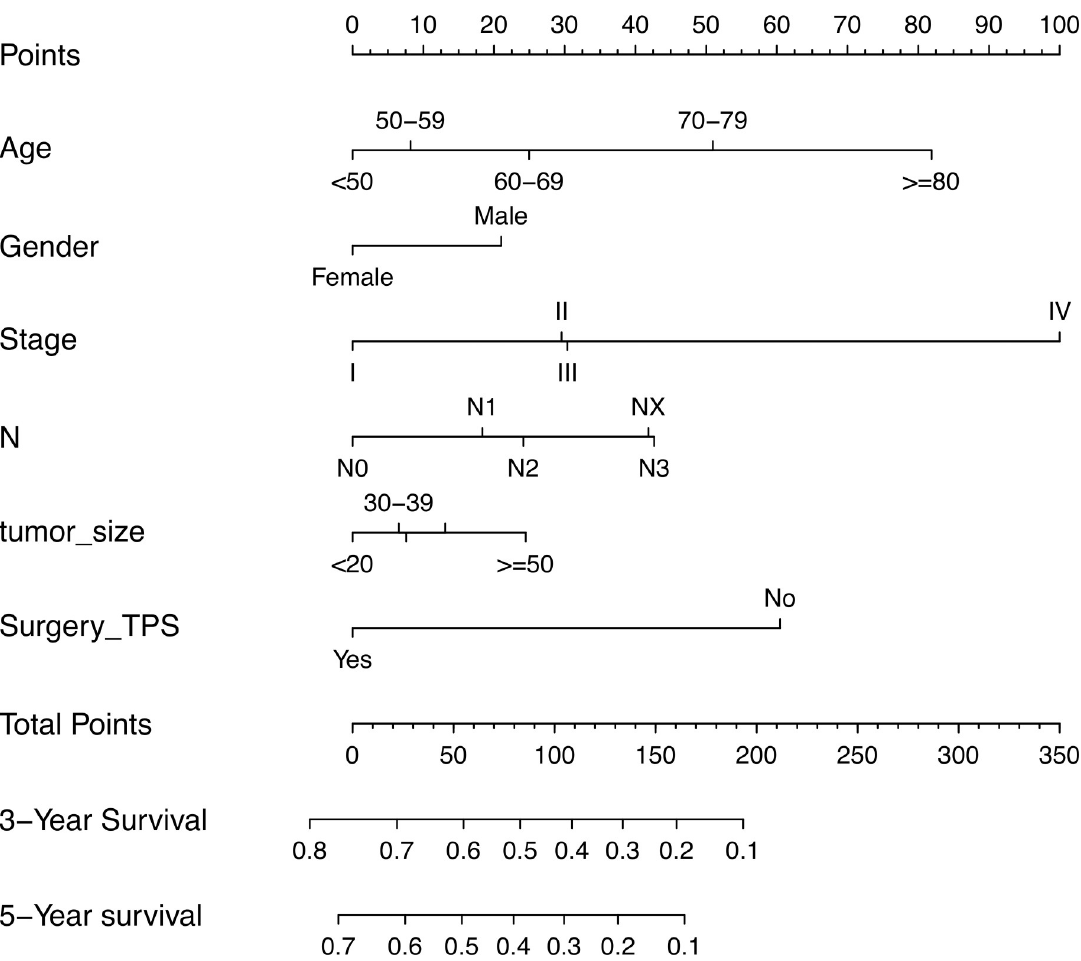
Fig 1. Nomogram predicting 3- and 5-year OS of patients with LCNEC. The nomogram summed the points identified on the scale for each variable. The total points projected on the button scale indicate the probabilities of 3- and 5-year